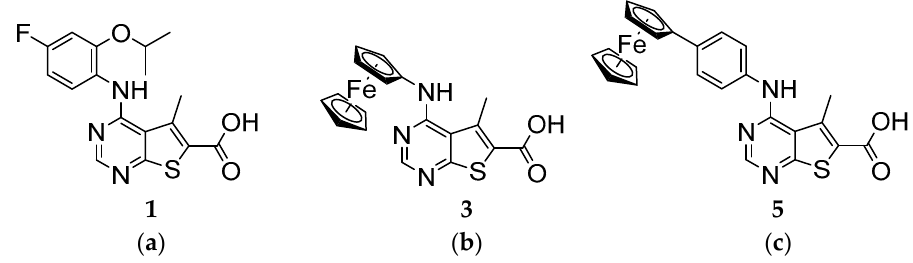
Figure 2. Chemical structures of compounds used in this study. ( a ) Structure of compound 1 , a MNK1/2 inhibitor, ( b ) ferrocene derivative, 3 , ( c ) ferrocene derivative, 5 .